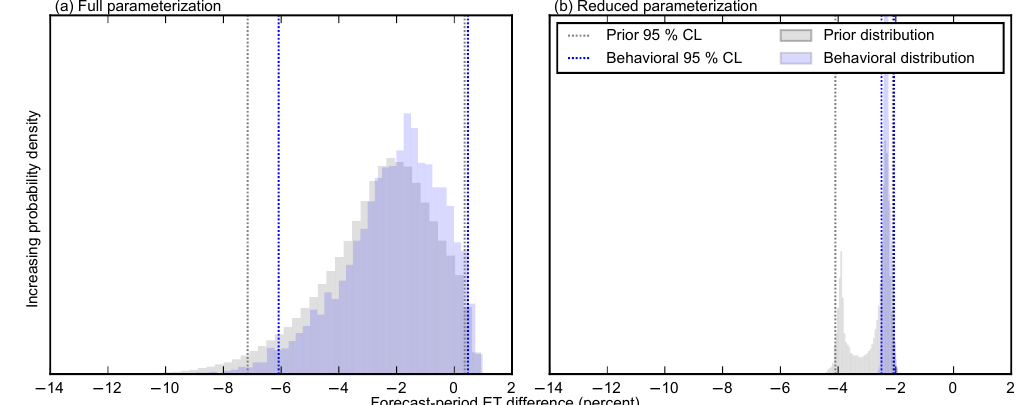
Figure 8. Quantity of interest QOI-5: simulated difference in total forecast period (posttreatment) ET volume as a result of brush management. Negative values indicate a decrease in ET as a result of brush management. The reduced parameterization yields a much narrower confidence interval compared to the full